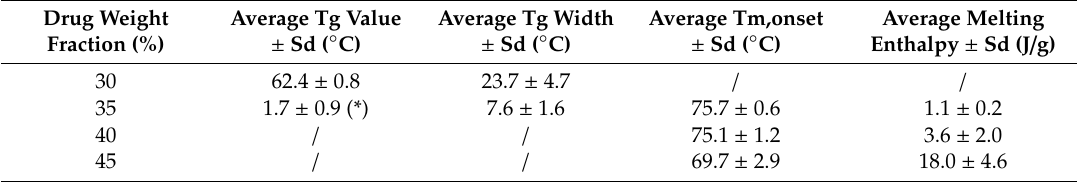
Table 1. Average T g values and widths ± standard deviation (sd) for MIC_PVP-VA_MeOH films. Average T m,onset values and melting enthalpies ± sd are reported as well.